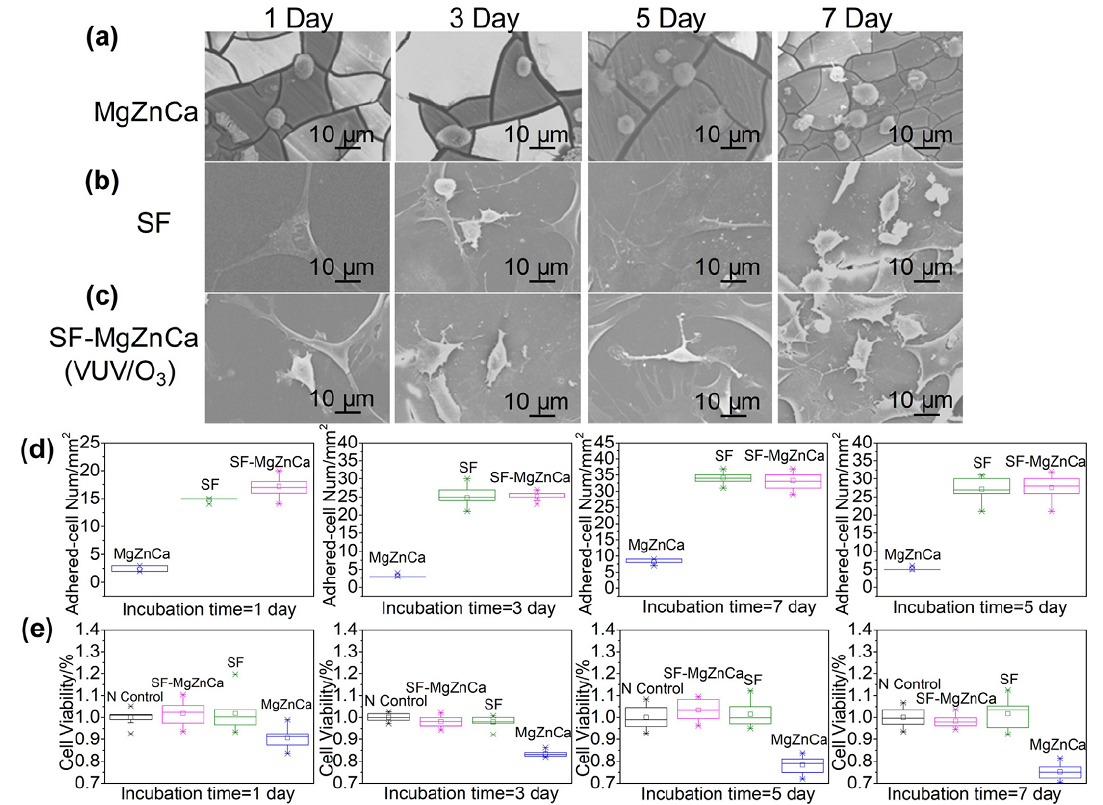
Figure 9. Morphologies of adhered cells on 1, 3, 5, and 7 days on the surface of ( a ) Bare MgZnCa, ( b ) Bare silk fibroin, and ( c ) SF–MgZnCa (VUV/O 3 ); ( d ) Adhered cell numbers per 1000 × field and ( e ) Cell viability of BMSCs indirectly cocultured with bare MgZnCa, bare silk fibroin, and SF-MgZnCa (VUV/O 3 ). Reprinted with permission from [92]; Copyright 2019 Elsevier. Table 2. Effects of natural polymer coatings and composite coatings parameters on Mg-based material properties. Substrate